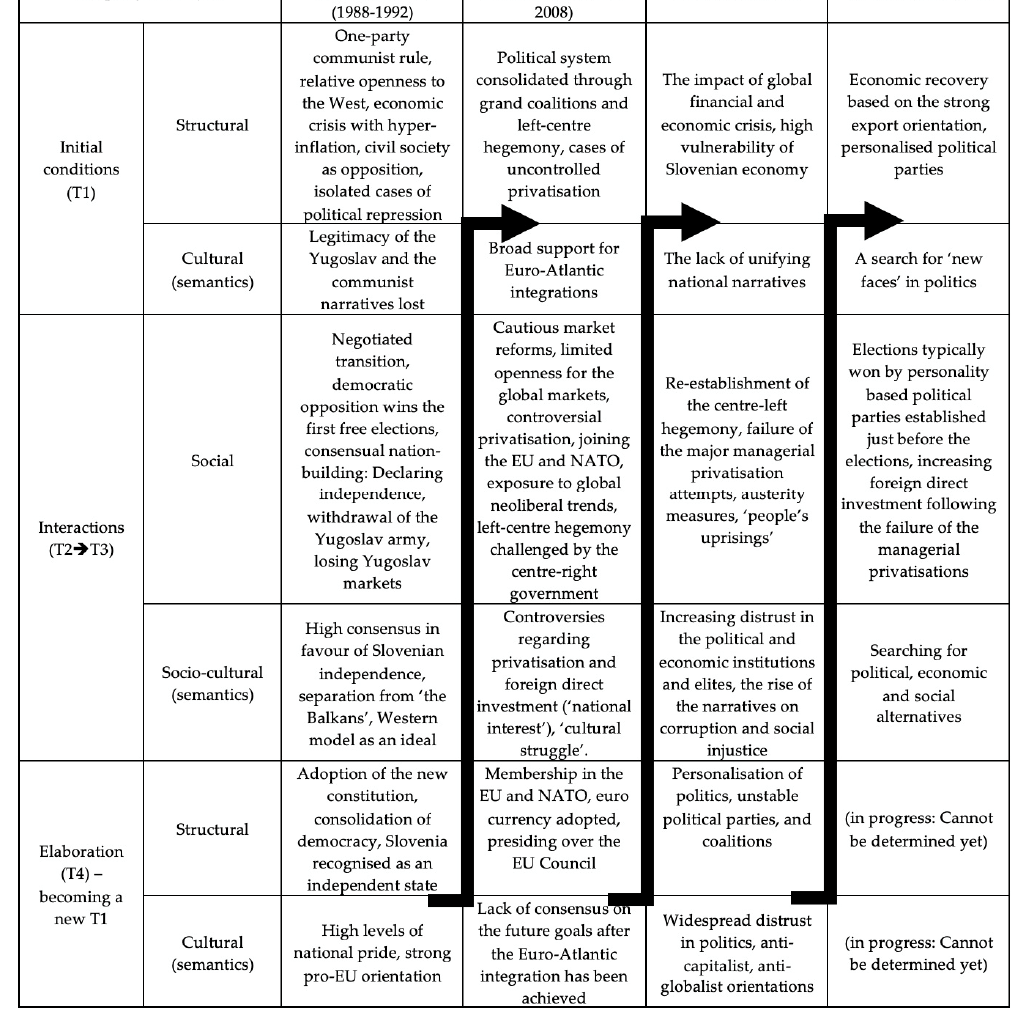
Figure 1. Morphogenetic cycles of the Slovenian post-communist society.